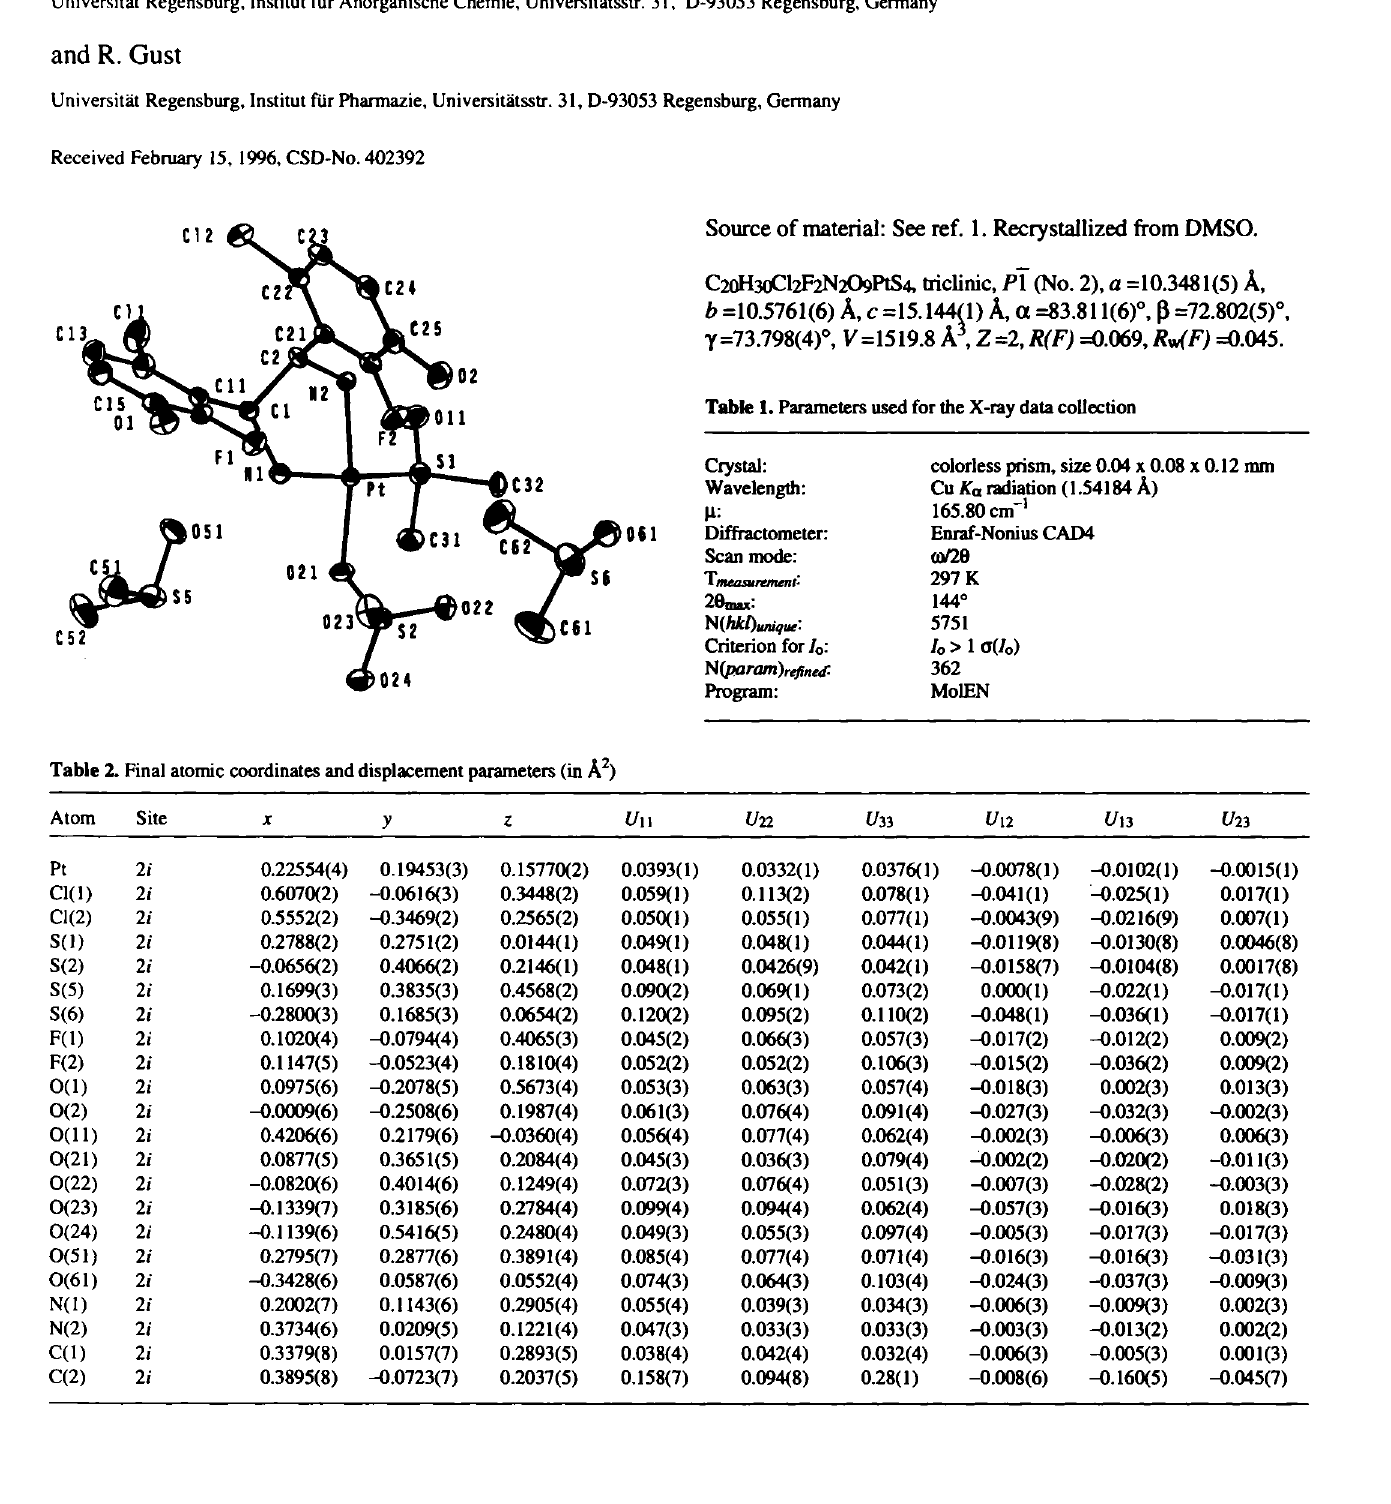
Table 1. Parameters used for the X-ray data collection Crystal: